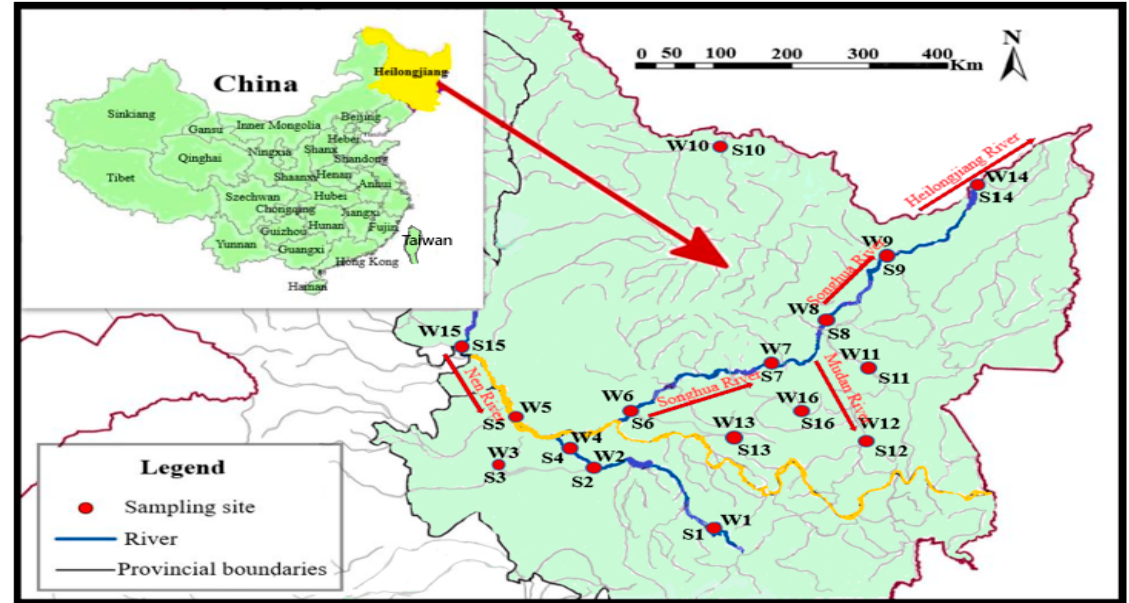
Figure 1. S ampling locations in the Songhua River Basin, including sediment and water. Figure 1. Sampling locations in the Songhua River Basin, including sediment and